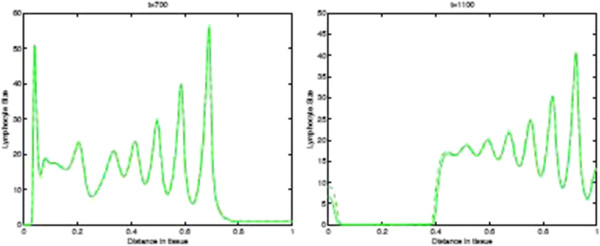
CTLs Spatial density in presence of immunoevasive mechanisms. Plots showing the distribution of CTLs within the tissue at times corresponding to 100, 400, 700, and 1100 days respectively. These plots illustrate the spatiotemporal onset of immunoevasion. The final plot at t=1100 should be compared to the equivalent plot in Figure 10, whereas the plot in the left panel, referring to time t=700 days, is analogous to the equivalent plot in Figure 10. These plots suggests that the onset of immunoevasion occurs after t=700 days. Parameter values pN=0.75 and ki+=constant. Solid line with chemorepellent, dashed line without.